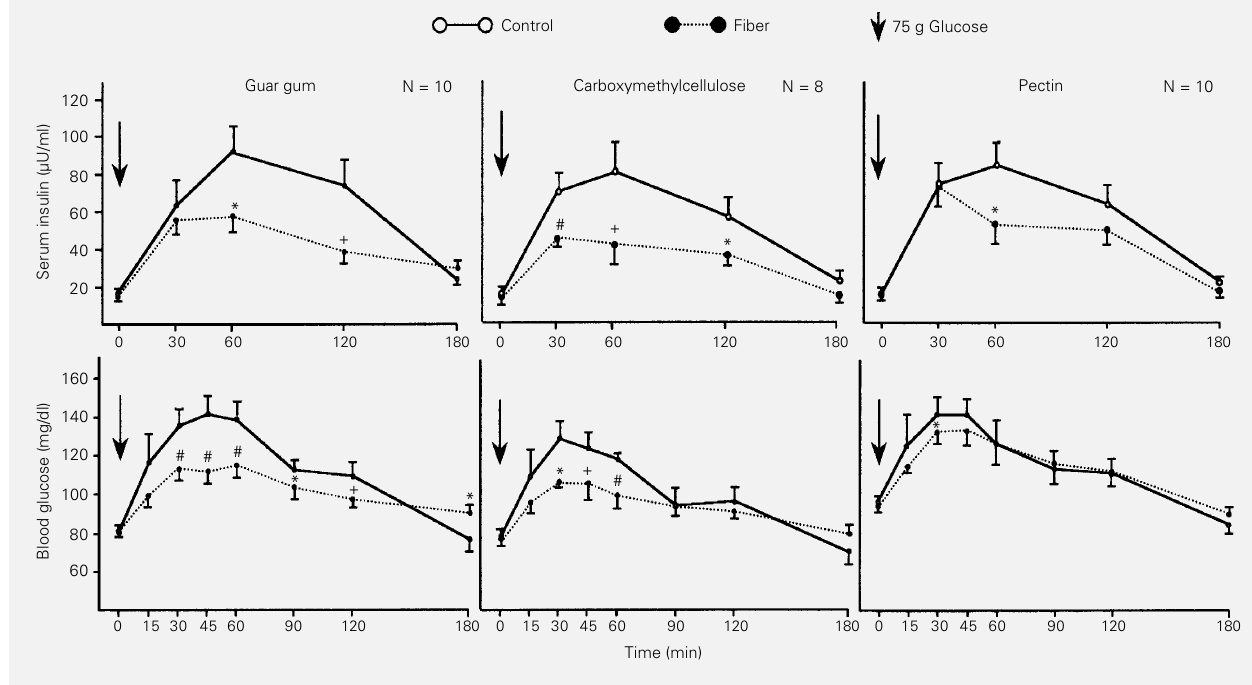
Figure 2 - Effect of a fiber-containing test meal on plasma glucose and serum insulin concentrations of volunteers after taking 75 g glucose (test meal) and fiber-containing test meals. *P<0.01, + P<0.05 and # P<0.001 compared to control ( t -test for paired